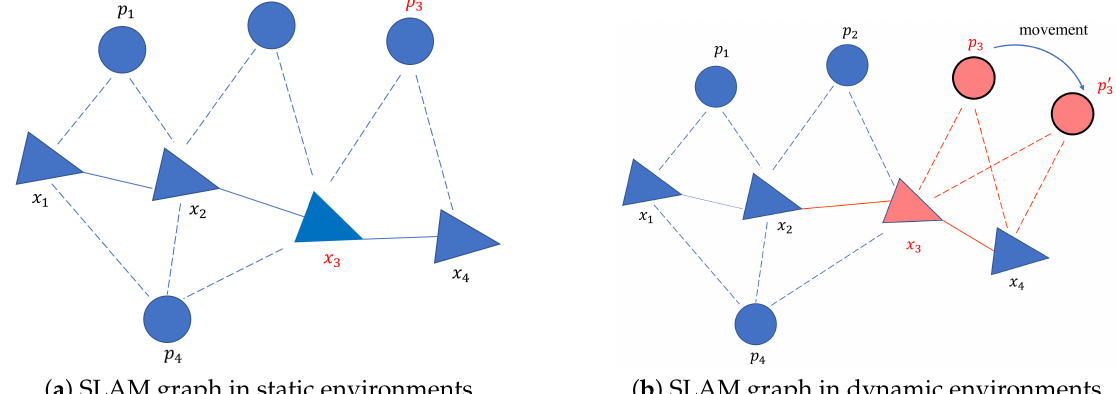
Figure 1. Illustration of the graph optimization model in Simultaneous Localization and Mapping (SLAM). The circles { p 1 , p 2 , p 3 , p 4 } represent landmarks. In addition, the triangles { x 1 , x 2 , x 3 , x 4 } represent camera poses. The solid edges link camera poses. The dotted edges link the camera poses and observed landmarks. In ( a ), the camera poses are estimated normally when all of the landmarks are static. In ( b ), the landmark p 3 has moved to the p (cid:48) position at the next moment. Red triangles x 3 3 and lines represent the pose error and constraints obtained with dynamic objects. The interference of dynamic objects is clearly illustrated by comparing the two